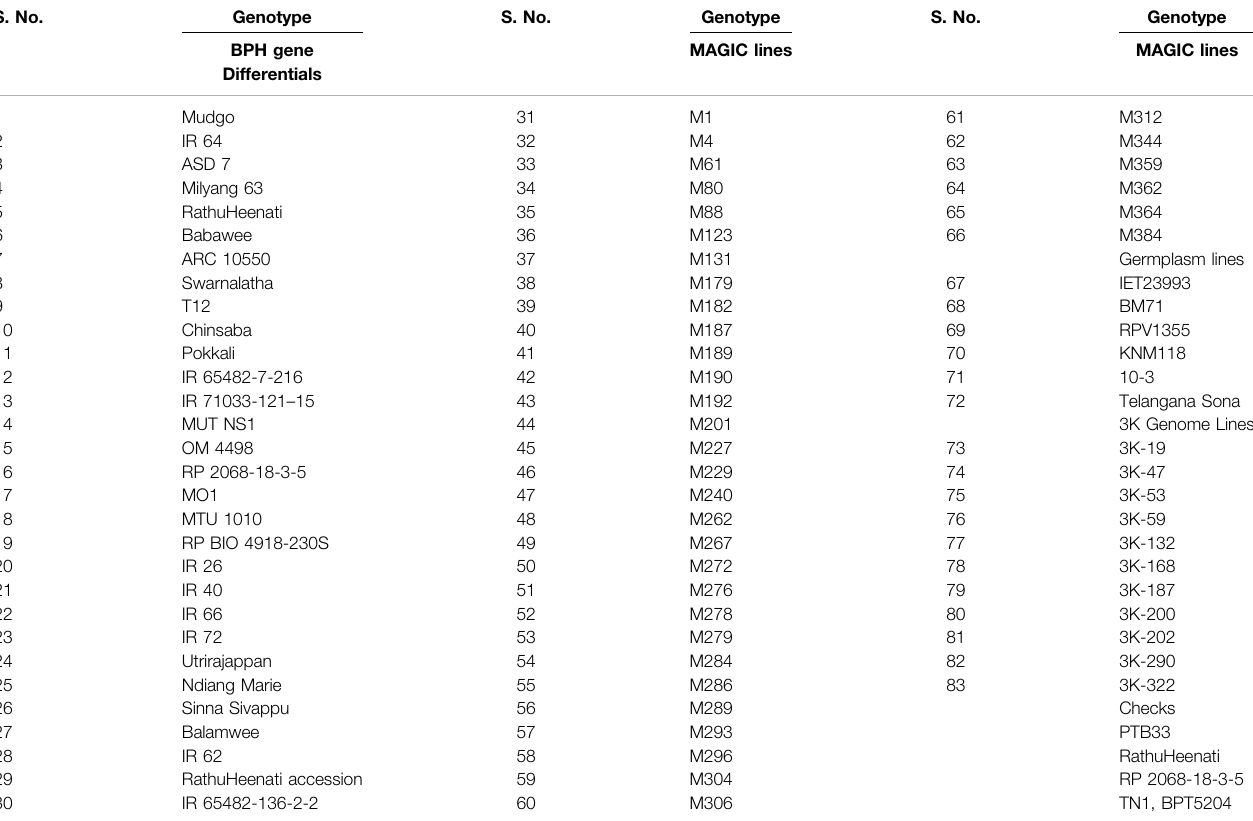
TABLE 1 | List of 83 genotypes and checks used in the study. S.